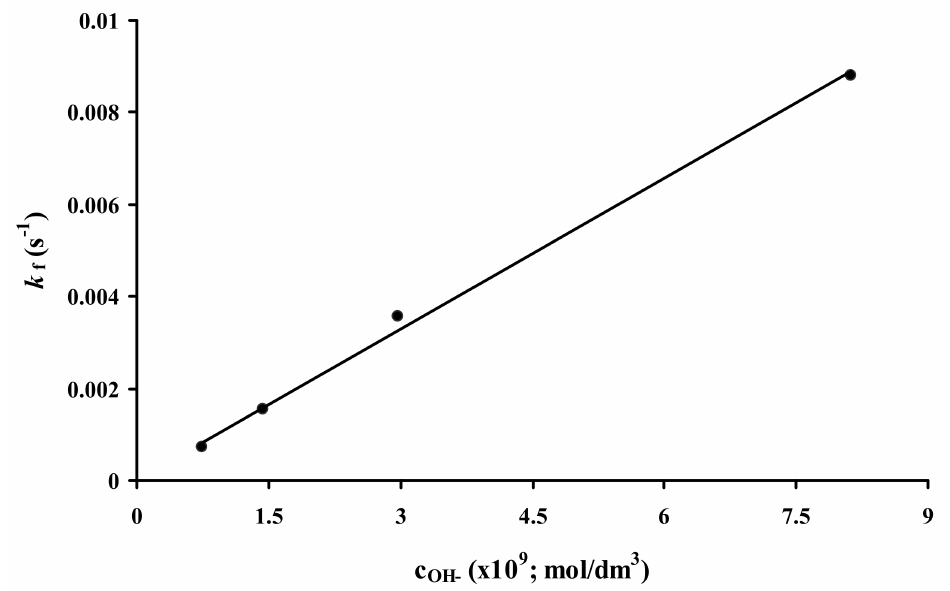
Figure 3. Formation rate constants, k f (s − 1 ), as a function of OH − concentration for the Eu(DO3A- ACE) − complex (25 ◦